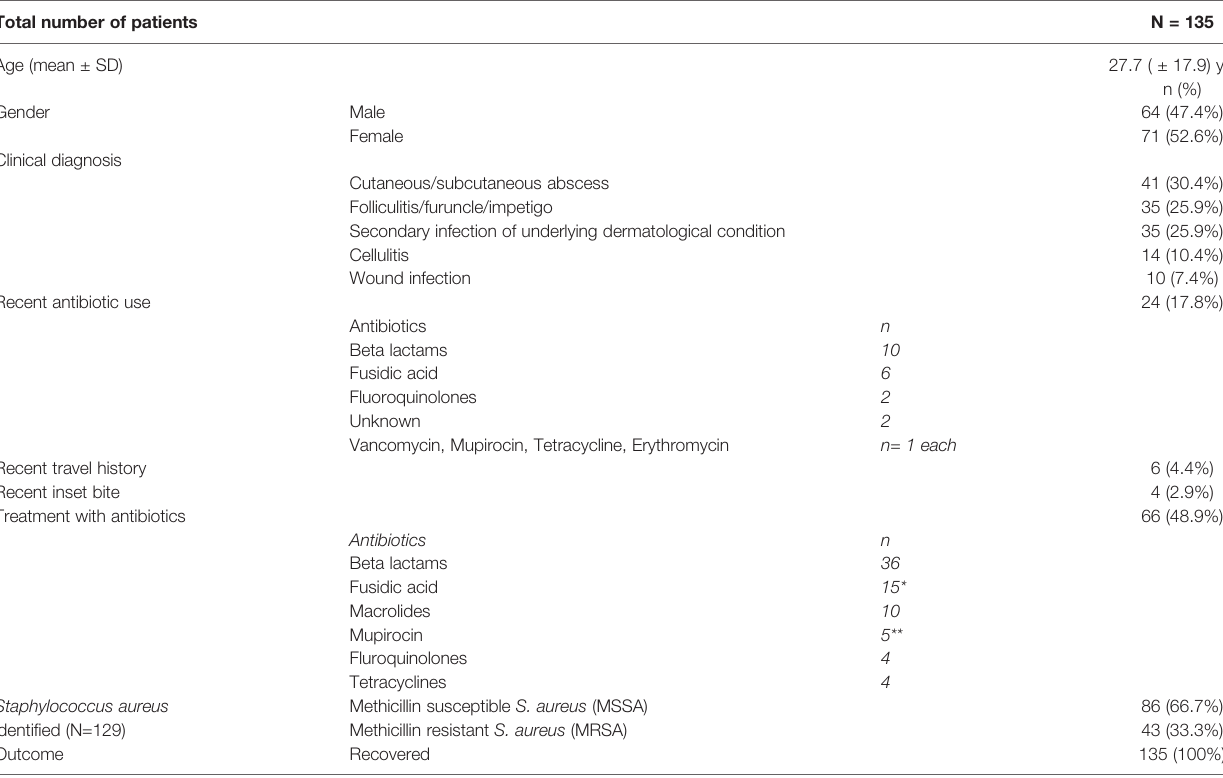
TABLE 1 | Demographic and Clinical Pro fi le of patients with skin and soft tissue infections. Total number of